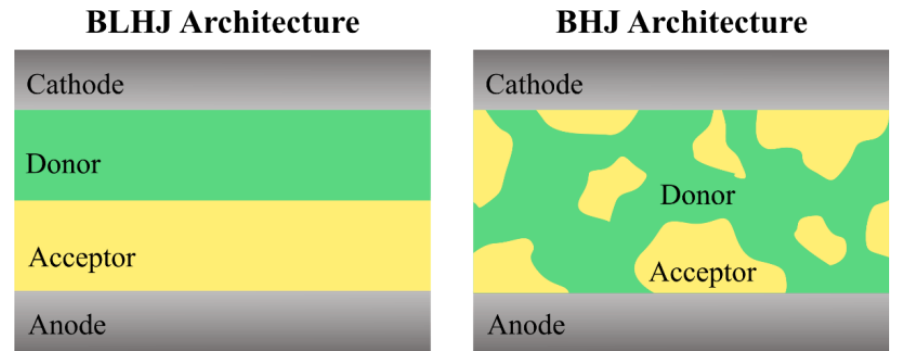
Figure 3. BLHJ and BHJ arrangements of an OSC